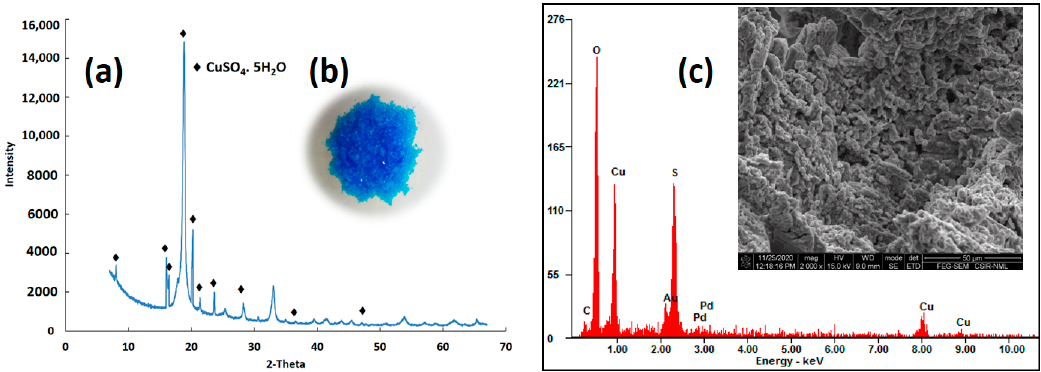
Figure 14. Characterization of the stripped and crystallized product of copper sulfate ( a ) XRD diffractogram; ( b ) 99.9% pure copper sulfate crystals; ( c ) SEM of Cu product.